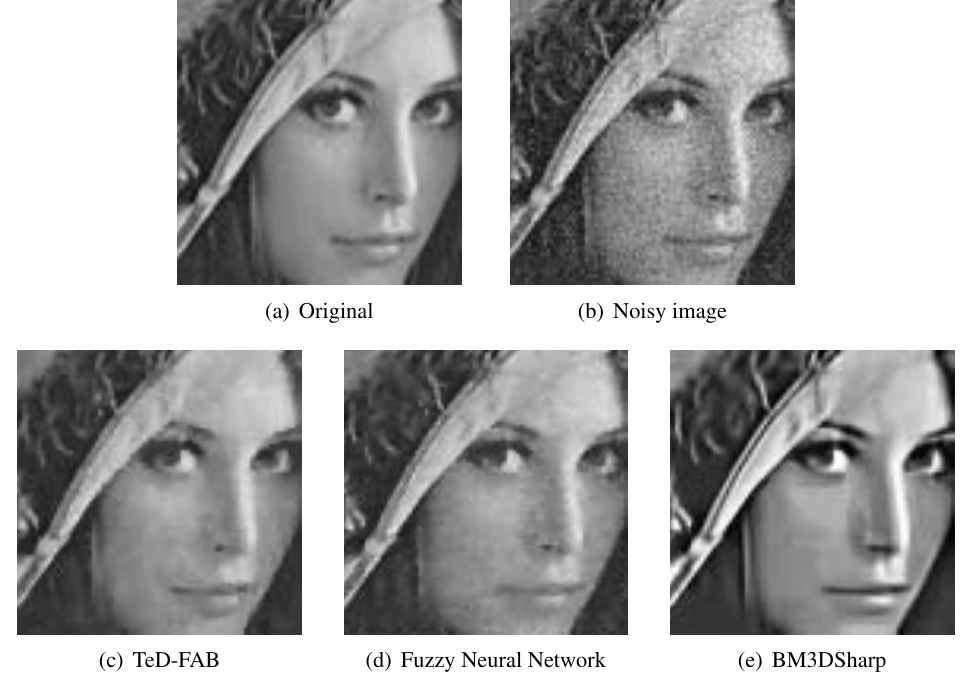
Fig. 10 Denoising results for Lenna image corrupted by Gaussian noise with standard deviation σ =